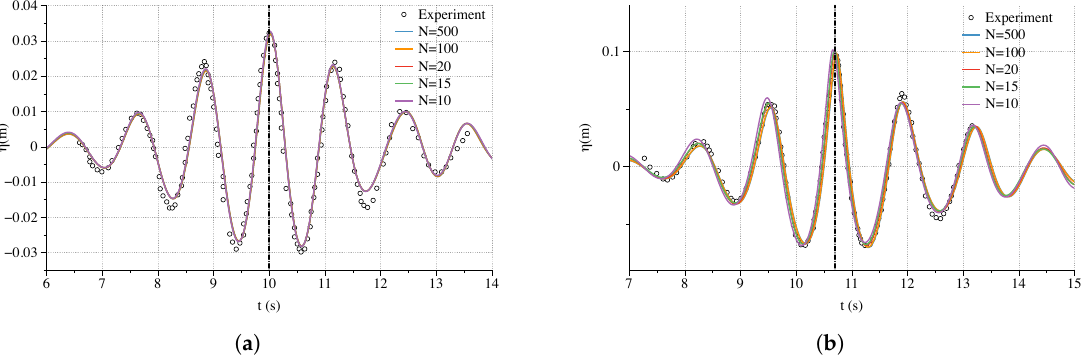
Figure 12. Convergence study of the number of frequency components, ( a ) the time series at the focusing location x = 7.5 m for case NING1, ( b ) the time series at the focusing location x = 8.475 m for case NING3. The tested numbers of frequency components are N = 10, 15, 20, 100 and